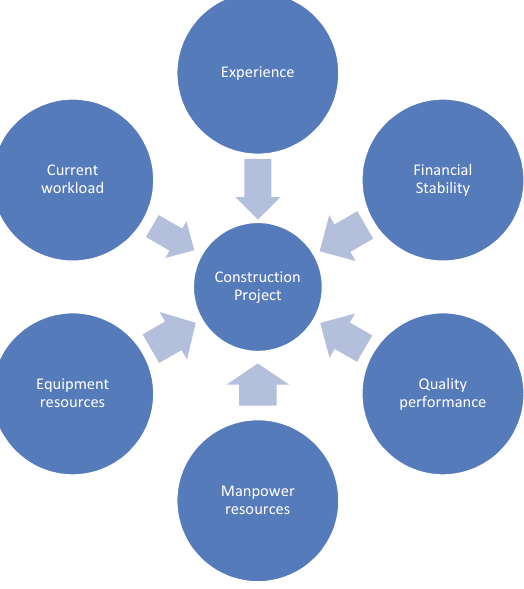
Fig. 1. The criteria influencing on choosing a construction project (Al-Harbi,